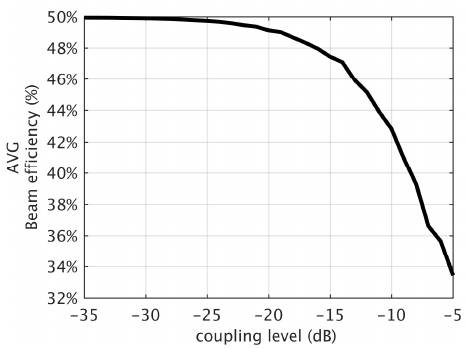
Figure 5. Beam efficiency varies with the coupling level.